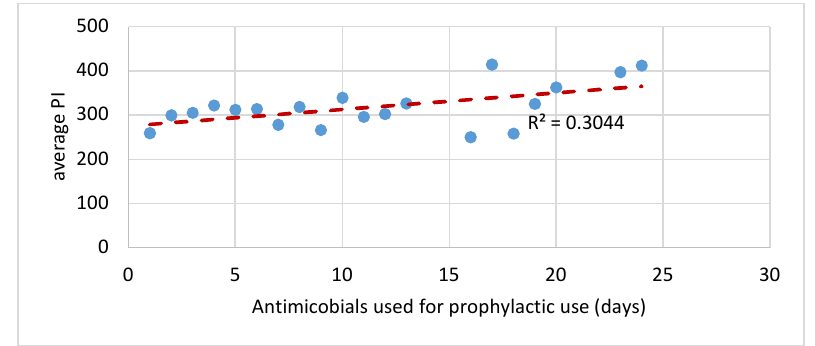
Figure 5. The correlation between average performance index (PI) and antimicrobials use for prophylactic reasons.